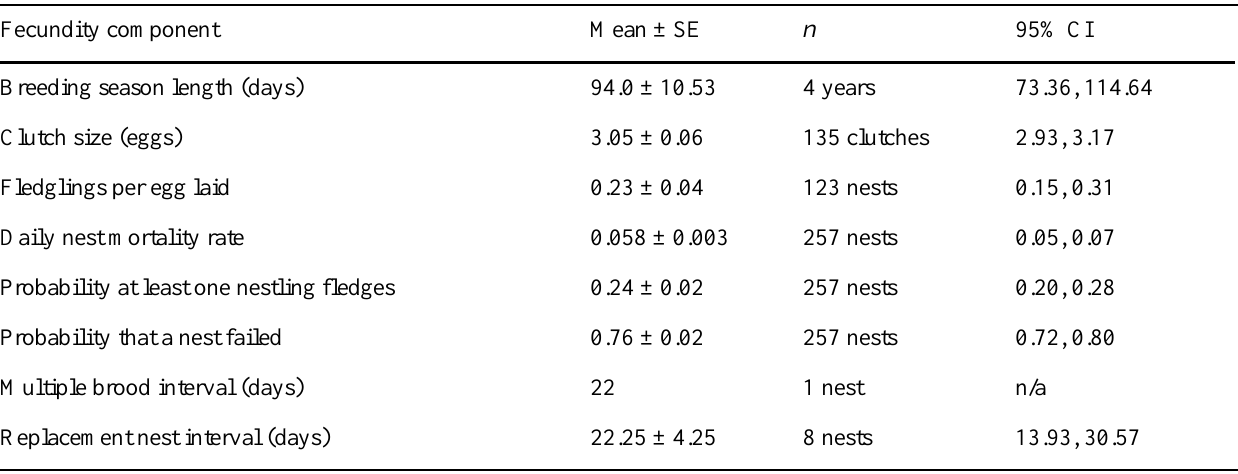
Table 1 . Estimates of the components of fecundity for Streaked Horned Larks in western Washington,